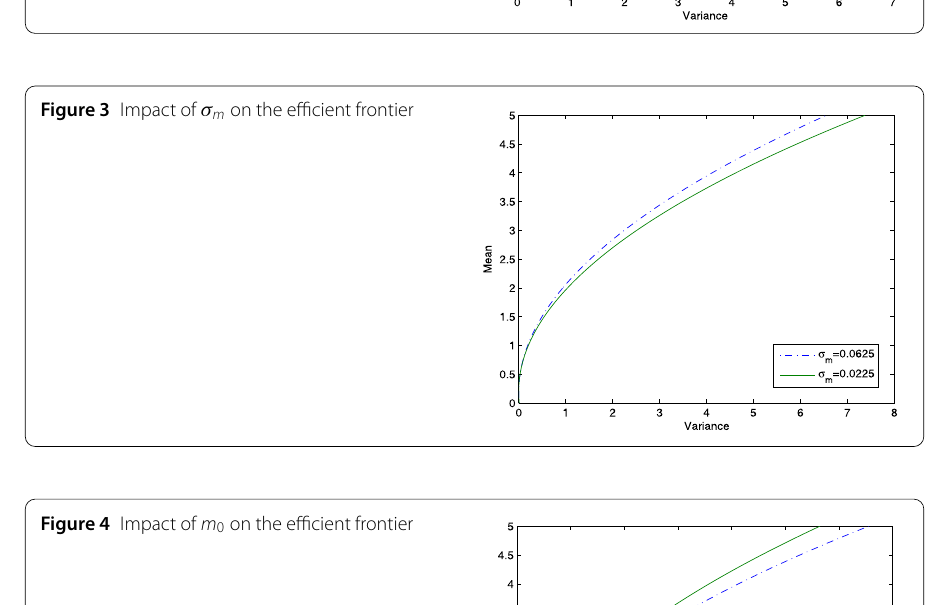
Figure 4 Impact of m 0 on the efficient